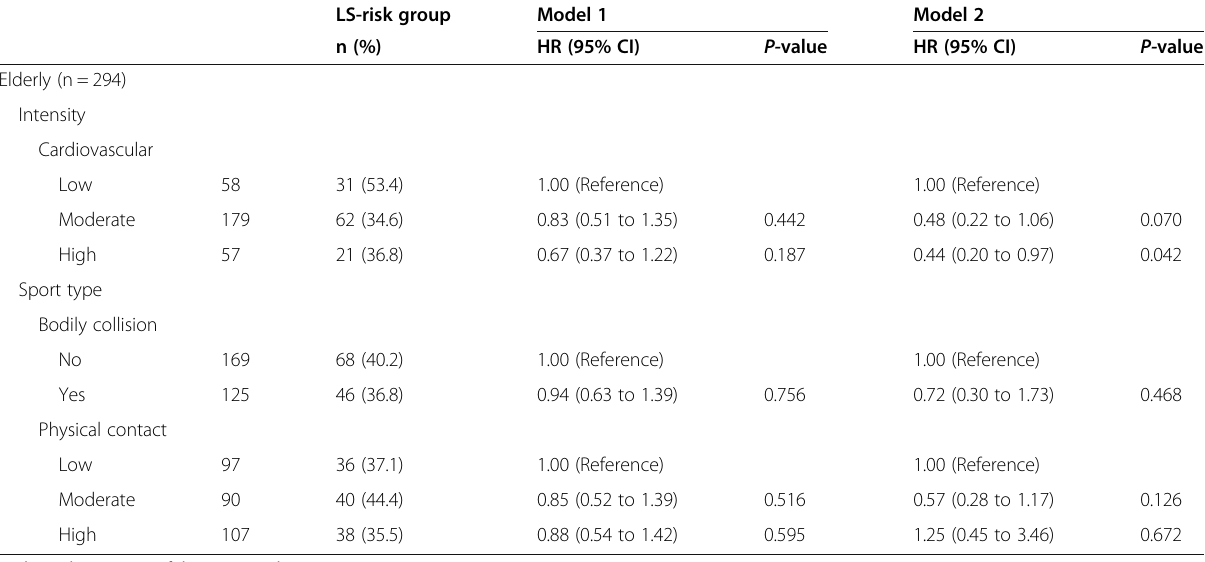
Table 5 Hazard ratios associated with locomotive syndrome according to different intensity of exercise and risk of bodily collision and physical contact based on elderly